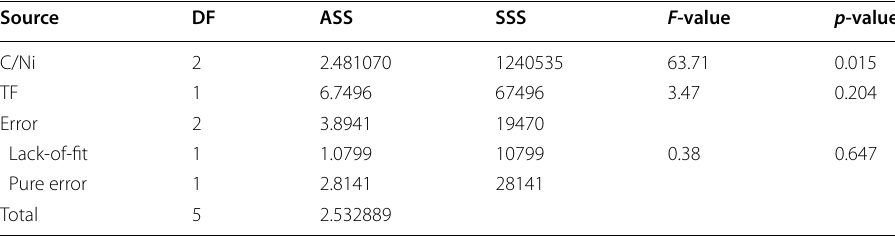
DF degrees of freedom, ASS adjusted sum of squares, SSS sequential sums of squares